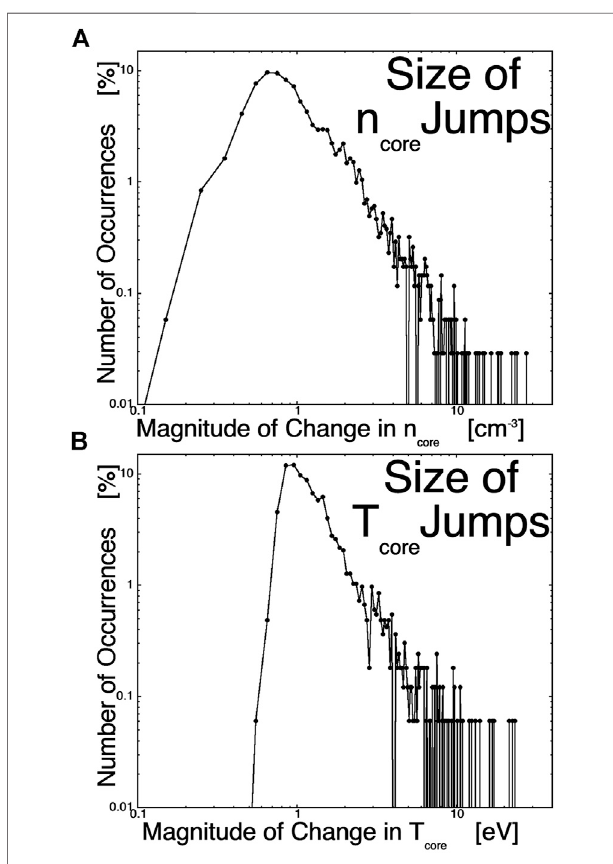
FIGURE 5 | The distributions of jump sizes for the identi fi ed number- density boundaries [panel (A) ] and for the identi fi ed temperature boundaries [panel ( B )] are plotted. Note that the binning used linear bi sizes (horizontal axis), but the bin values are plotted